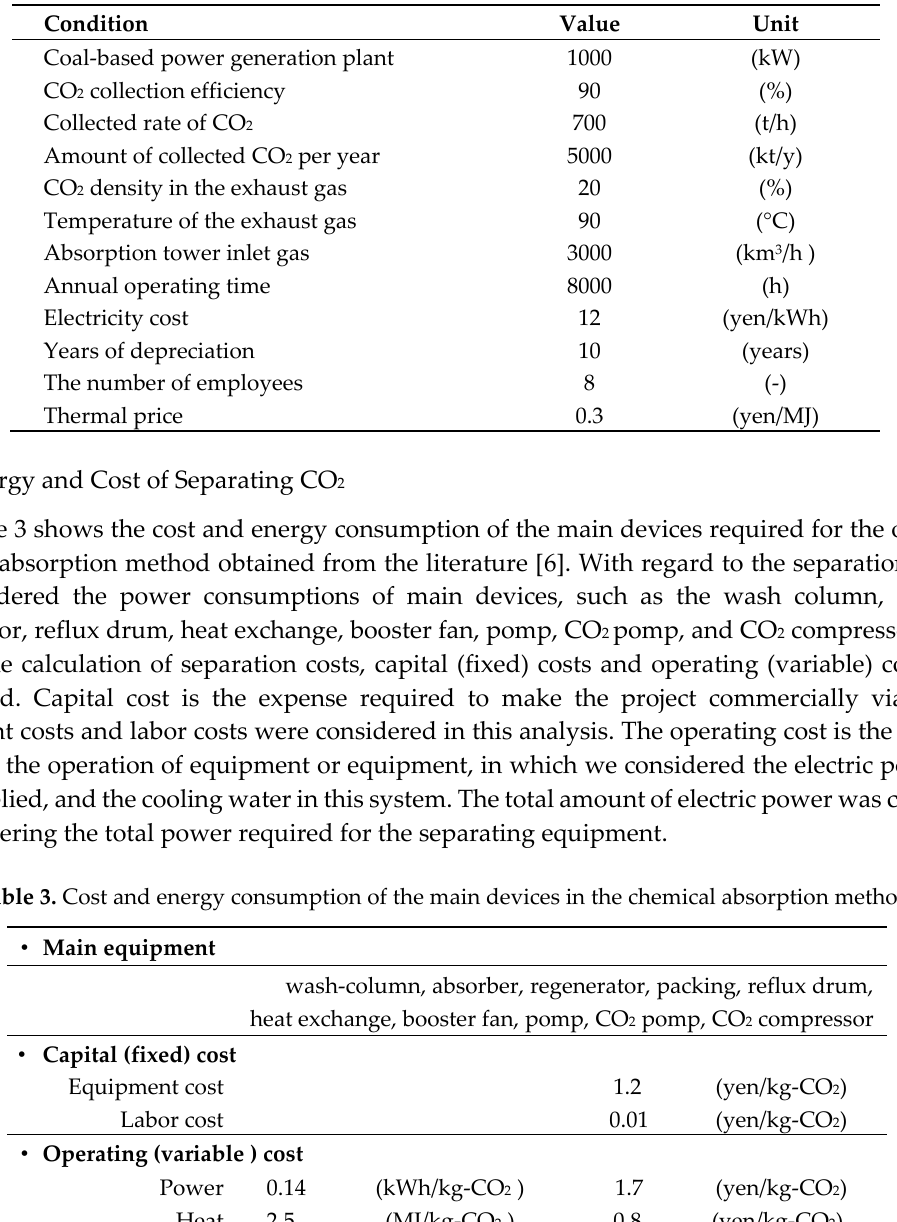
Table 2. Conditions for calculating energy and cost.